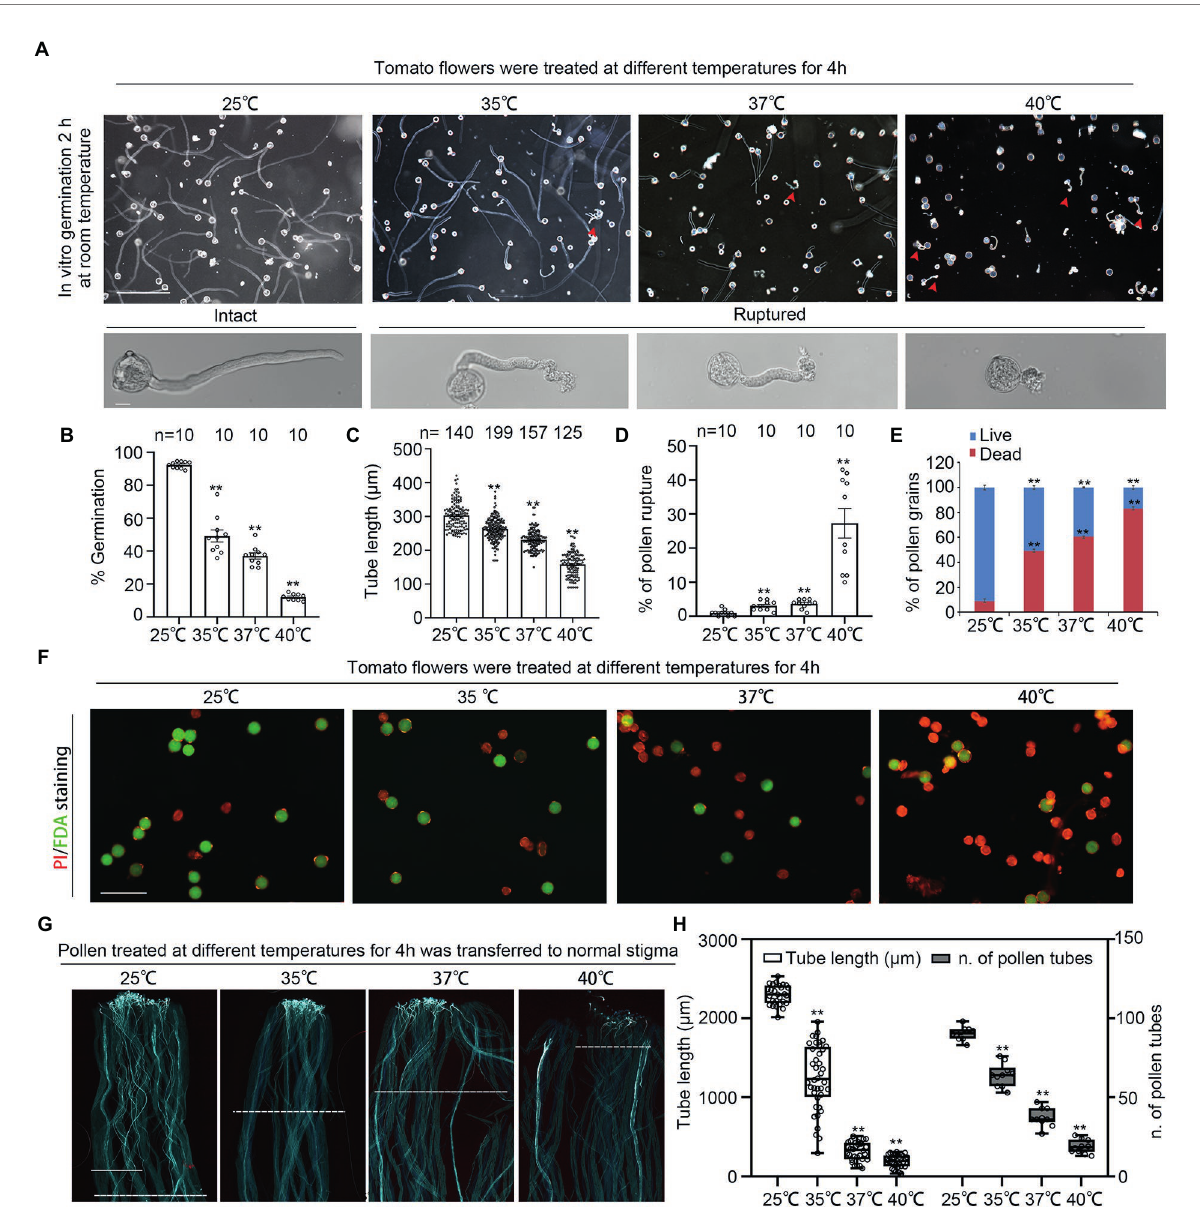
FIGURE 1 Short-term Heat stress decreases pollen viability and pollen growth. (A) Growth of pollen under 4 h treatment with different temperatures, 25, 35, 37, 40 ° C. Red arrows indicate ruptured pollen. Scale bars, 200 μ m (upper panel), 10 μ m (lower panel). (B,C) Quantification of pollen germination and tube length in (A) . n denotes the number of observation views (B) and pollen tubes (C) . Rupture of pollen in (A) . n denotes the number of observation views. (E,F) Dual-staining with fluorescein diacetate (FDA) and propidium iodide (PI) shows pollen viability under 4 h of treatment with different temperature (25, 35, 37, 40 ° C). Scale bars, 100 μ m. (G,H) Growth of heat stress-treated pollen in normal pistils. Scale bars, 500 μ m. Bars represent means ± SE m. Asterisks or n.s. right above the data bars indicate significant difference (two-tailed t -test, ** p < 0.01) or no significant difference compared with the data bars on the far left. All experiments have 3 biological replicates and they have similar